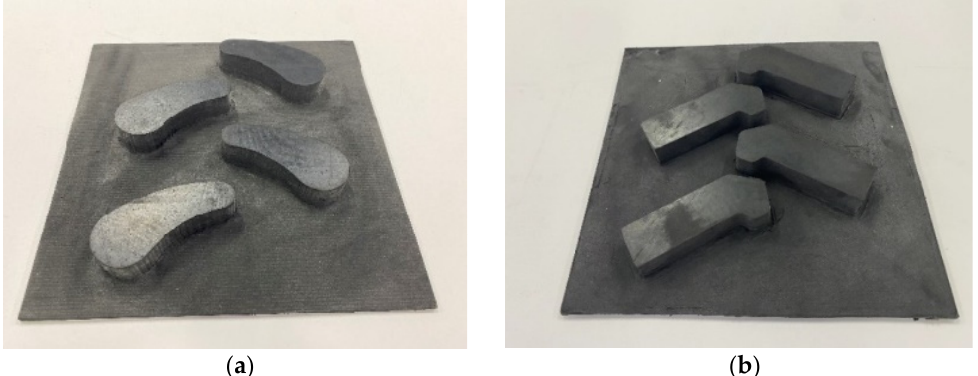
Figure 7. Tire block specimen: ( a ) bionic tire-block specimen I; ( b ) ordinary tire-block specimen I.